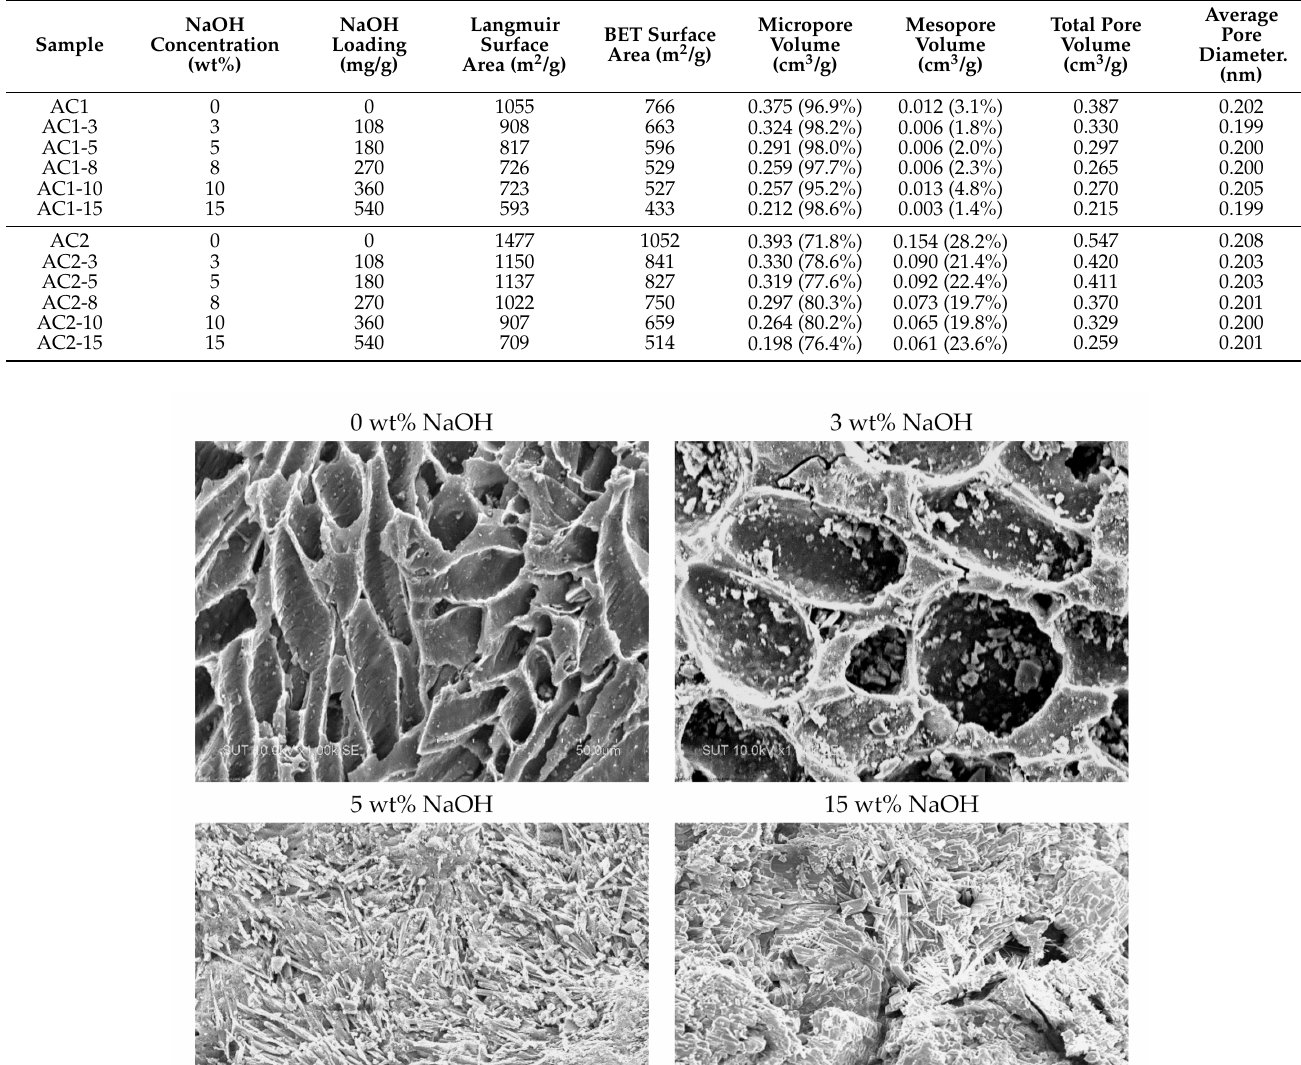
Table 2. Porous properties of the original and NaOH impregnated activated carbons.